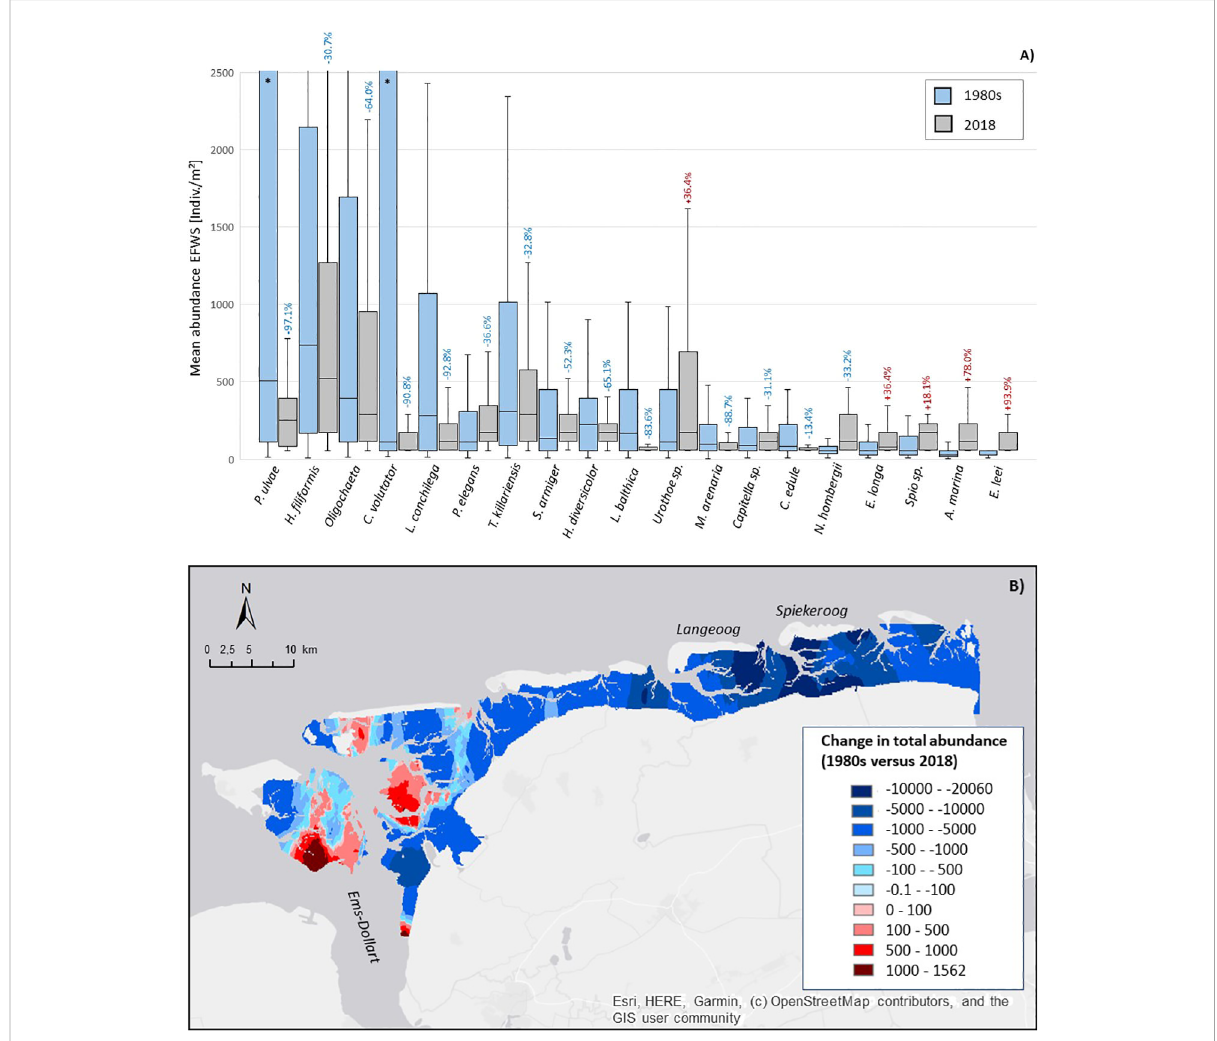
FIGURE 4 Spatio-temporal changes in the abundance of the dominant species in the East-Frisian Wadden Sea (EFWS); (A) boxplot showing the changes in the mean abundance [Ind./m²] between the 1980s and 2018, with % total abundance decrease (1980 versus 2018, blue color) and % total abundance increase (1980 versus 2018, red color), *: the abundance of P. ulvae and C. volutator was limited in the graph to enhance data visibility of the other species, for the absolute values for P. ulvae and C. volutator see Table 2; (B) map of the total abundance change since the 1980s in the EFWS. Blue colors indicate a decrease in the total abundance between the 1980s and 2018, red colors indicate an increase in the total abundance between the 1980s and